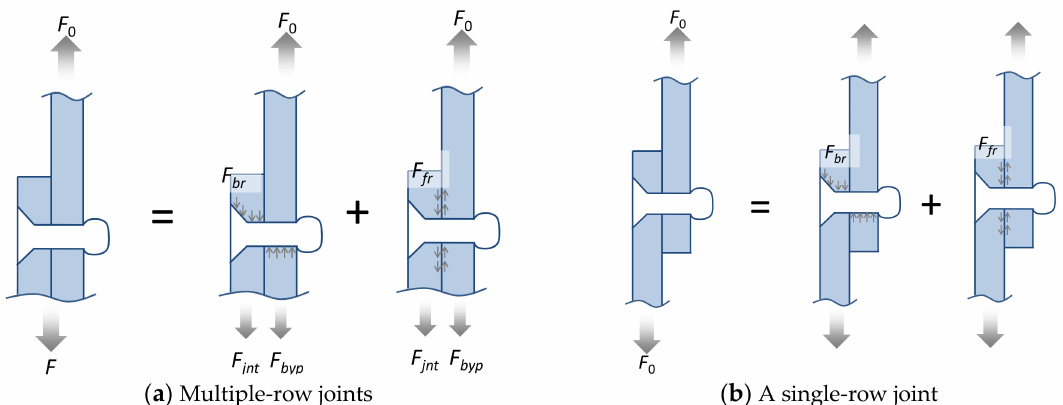
Figure 2. Definition of loads carried through rivet